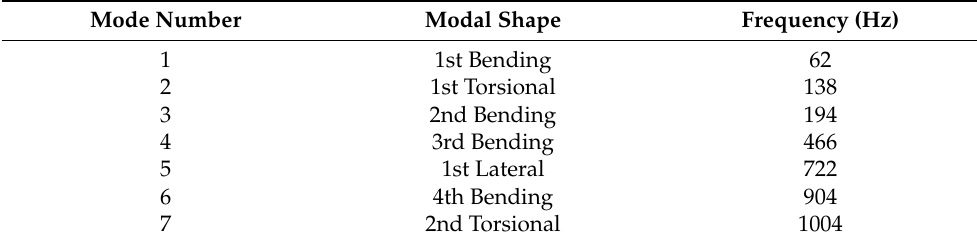
Table 1. Overall results of the modal analysis in the 0 – 1.1 kHz range.